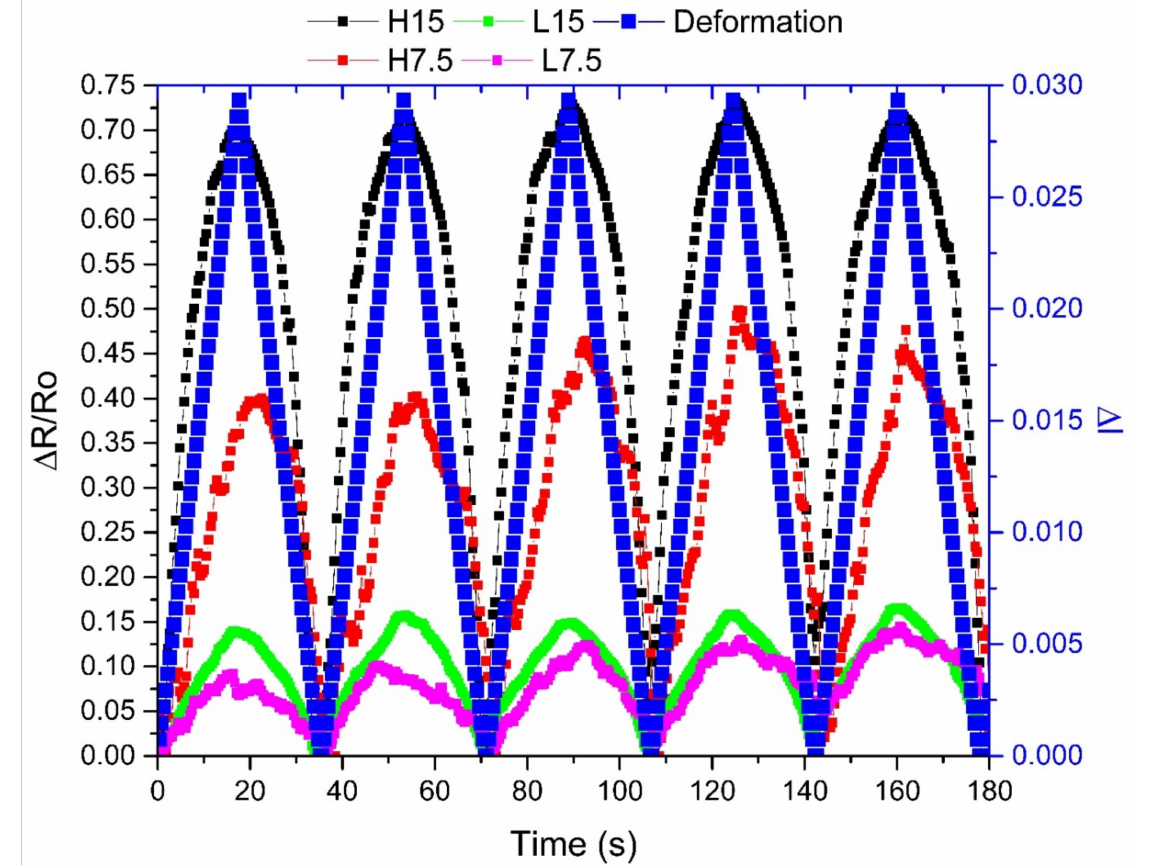
Figure 8. Piezoresistive curves (black axis) of the films with different GNPs concentrations (7.5 and 15 wt.%) and the strain curves (blue axis) over